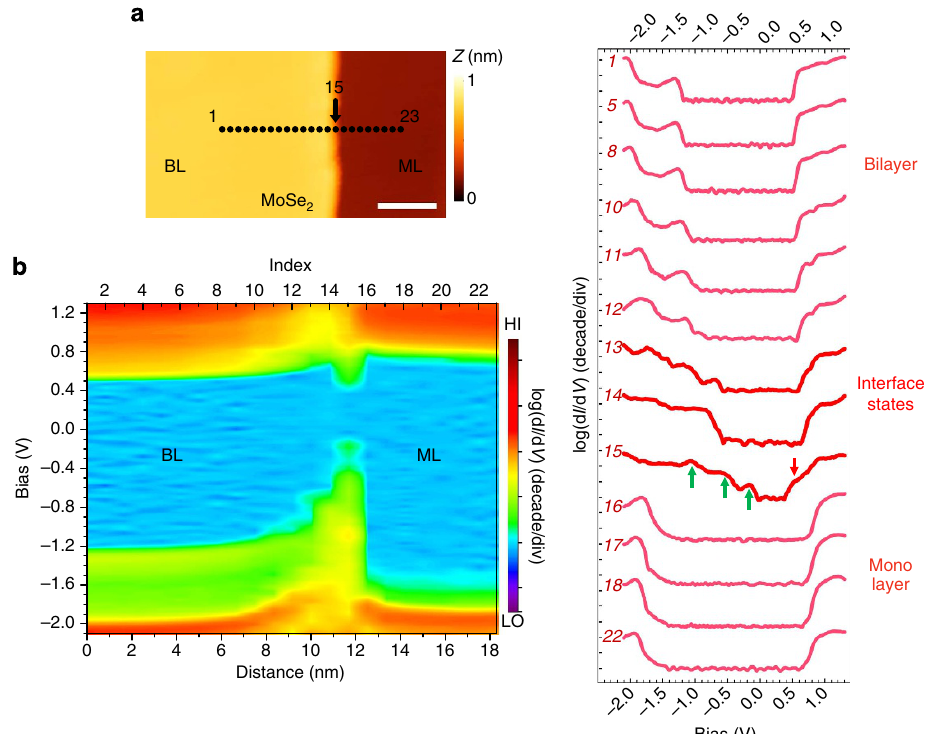
Figure 3 | Scanning tunnelling spectroscopy investigation of band profile across the BL–ML MoSe 2 heterojunction. Similar with Fig. 2, ( a ) is a close-up STM image showing the path line that spectroscopy was taken along. The total length is about 18nm with a step size of 0.8nm. The spectra numbers in b and c are counted from left to right in the path, while spectrum #15 was taken right at the BL–ML interface. ( b ) Colour-coded rendering of the real space imaging of band profile plotted in terms of log(d I /d V ). ( c ) Selective subset of log(d I /d V ) spectra. In spectrum #15, the interface states in valence band and conduction band are marked with green and red arrows, respectively. Scale bar, 5nm ( a